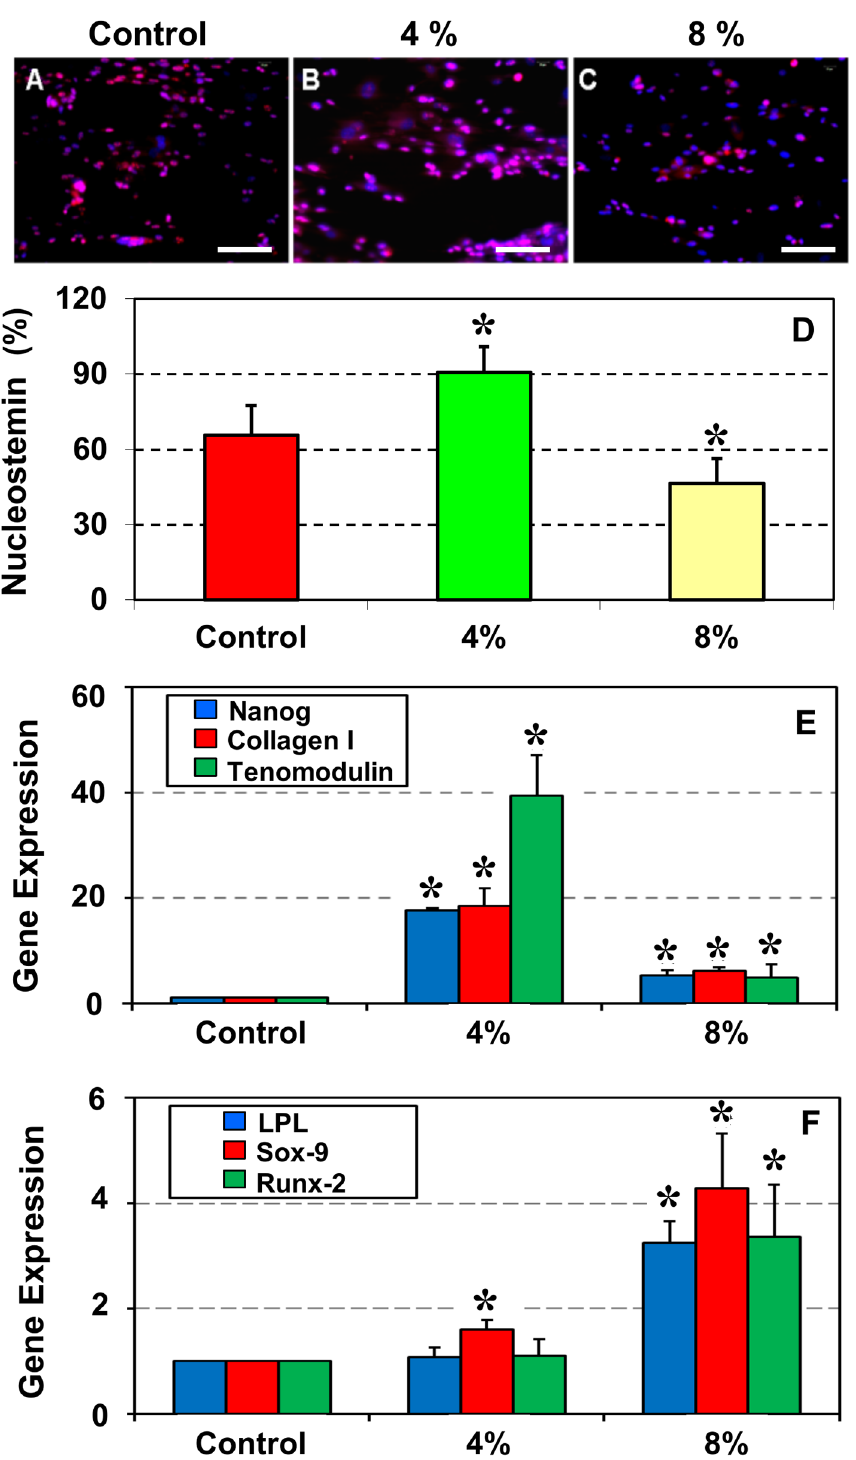
Fig 5. Immunostaining of nucleostemin (NS) (A – C), semi-quantitation (D) and qRT-PCR analysis of gene expression (E, F) in aging TSCs subjected to mechanical loading in vitro . Patellar TSCs isolated from aging mice (9 months old) were subjected to no stretching (Control), 4% stretching or 8% stretching followed by the analyses. Immunostaining ( A – C ) and semi-quantitation ( D ) showed that compared to the control without stretching, 4% stretching increased the number of NS-expressing TSCs, whereas